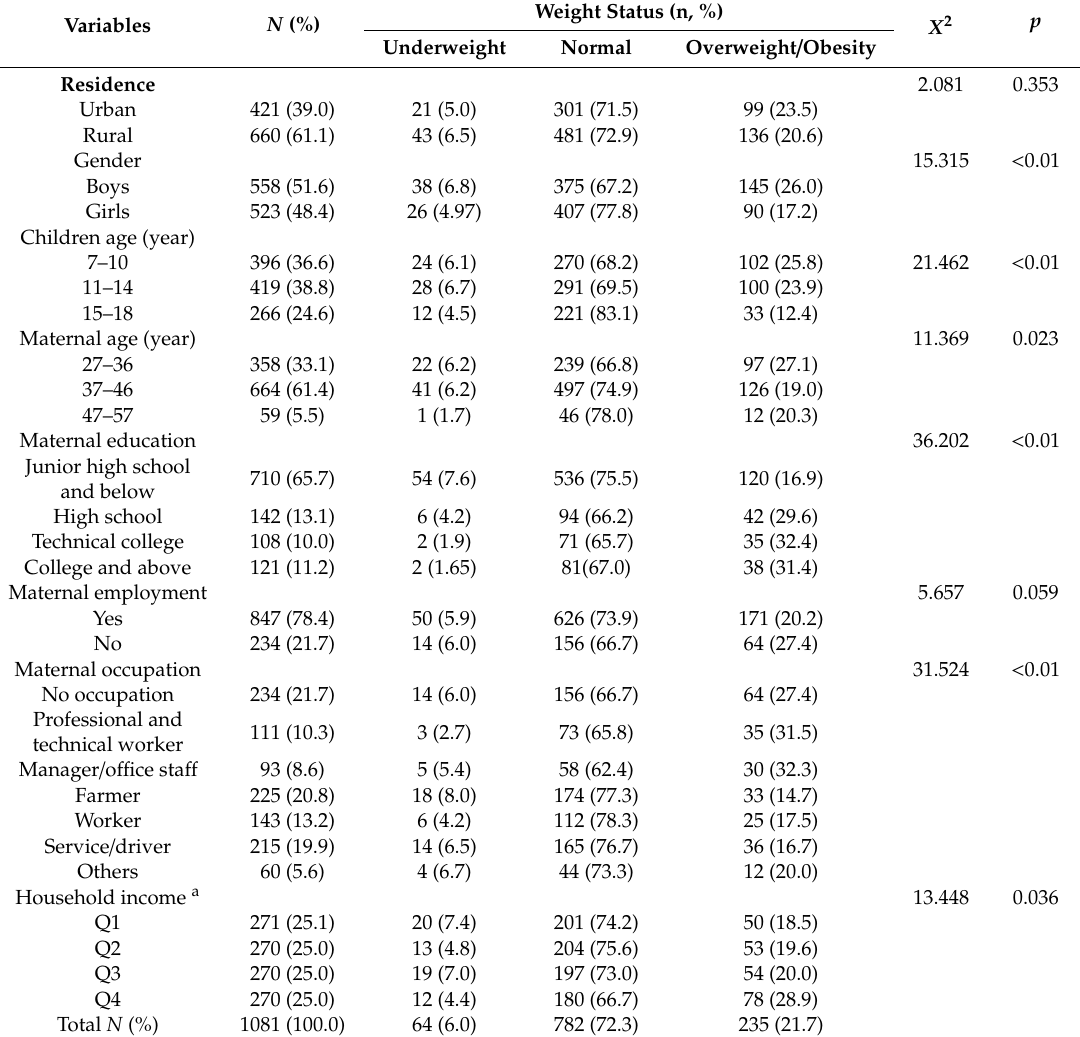
Table 3. Children’s weight status across di ff erent